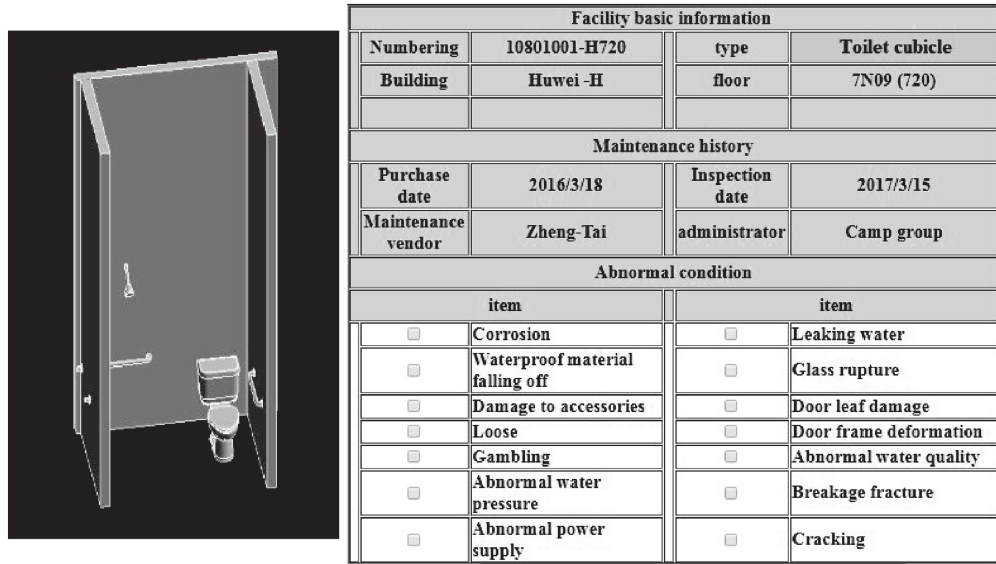
Figure 10: Illustration of the facility’s abnormal patterns for repair menu page.